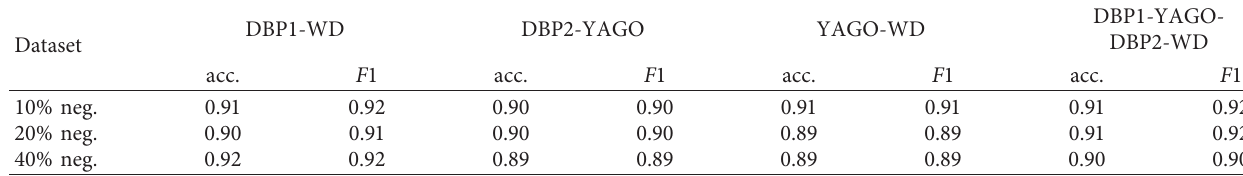
Table 5: Performance of multi-HITE over different datasets with different levels of